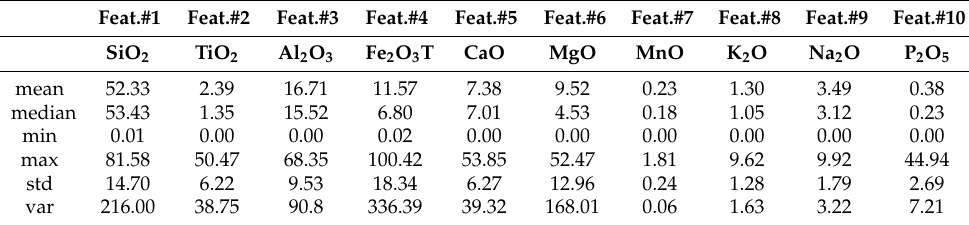
Table 4. Basic statistics of Dataset 2.